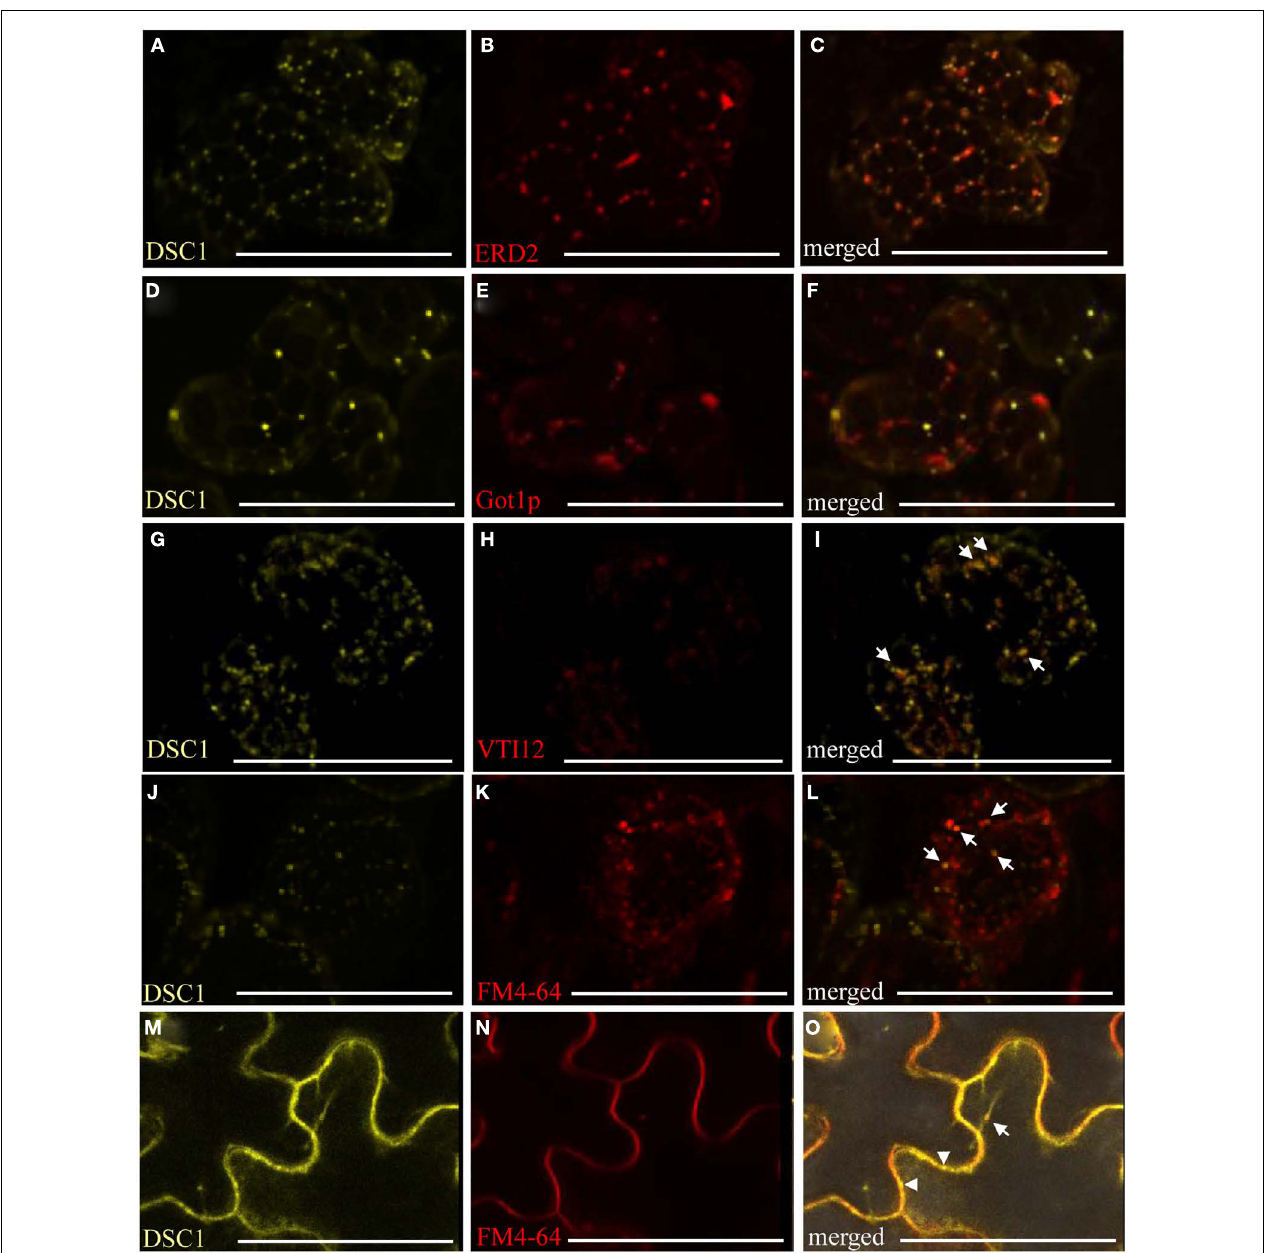
trans -Golgi/early endosomal marker UBQ10-mCherry<VTI12 [ (I) , merged] and (K,N) the endocytic tracer FM4-64 in mesophyll and epidermal cells [ (L,O) , merged]. Arrows point to compartments that co-localize withYFP-tagged DSC1. Arrowheads point toYFP-tagged DSC1 compartments at the plasma membrane. Scale bars represent